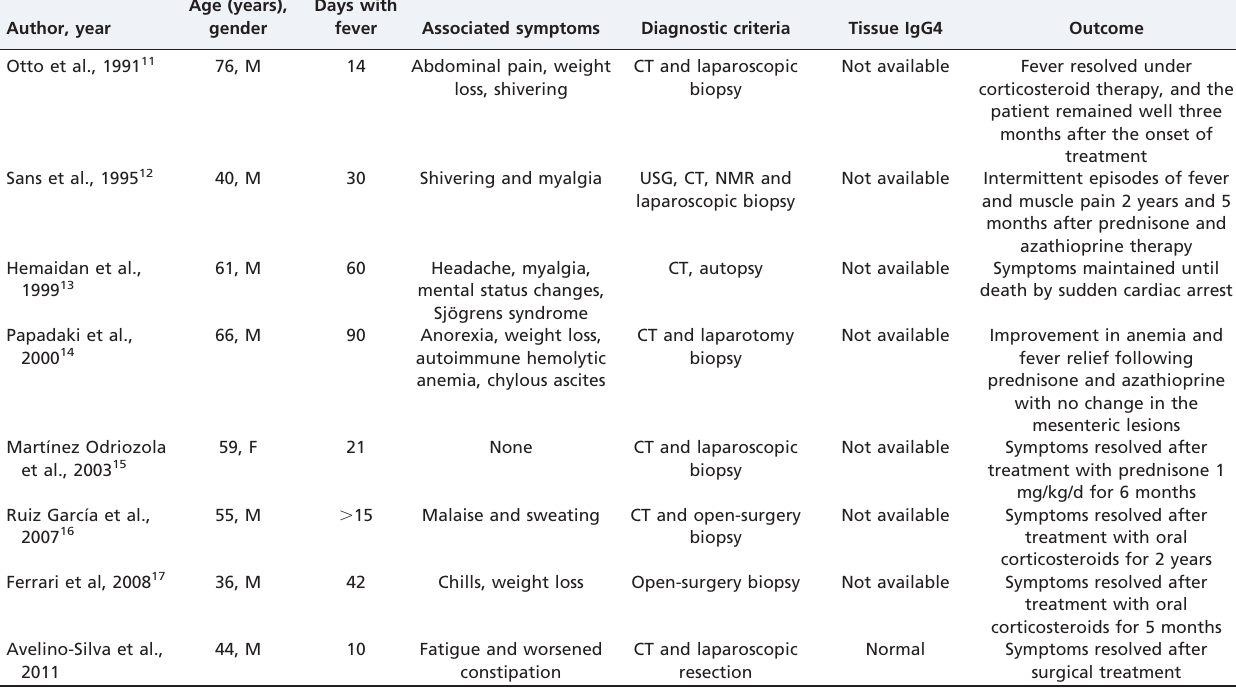
Table 1 - Case reports of sclerosing mesenteritis as a cause of